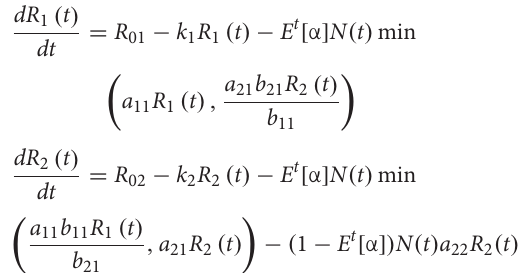
Region 3 of Figure 1 : With a moderate ratio of glucose to estrogen, the ER + cells will still be limited by estrogen. This means that they leave a level of glucose above their R ∗ ; however, if this level of glucose is below the R ∗ of the ER − cells, they will slowly and eventually be excluded from the community of cancer cells. In this region, the cancer will tend toward all ER + ( α = 1). The standing crop of resources will have estrogen at the R ∗ of the ER + cells, and the standing crop of glucose will be above that of the ER + cells and below that of the ER − cells. Region 4 of Figure 1 : With a low ratio of glucose to estrogen at the resource supply point, the ER + cells will be glucose limited and not estrogen limited. When this happens, they will drive glucose levels down to their R ∗ for glucose. Since this is lower than the R ∗ on glucose for the ER − cells, the ER − cells will be outcompeted from this community. One should see a rapid equilibration on a community of just ER + cancer cells ( α =